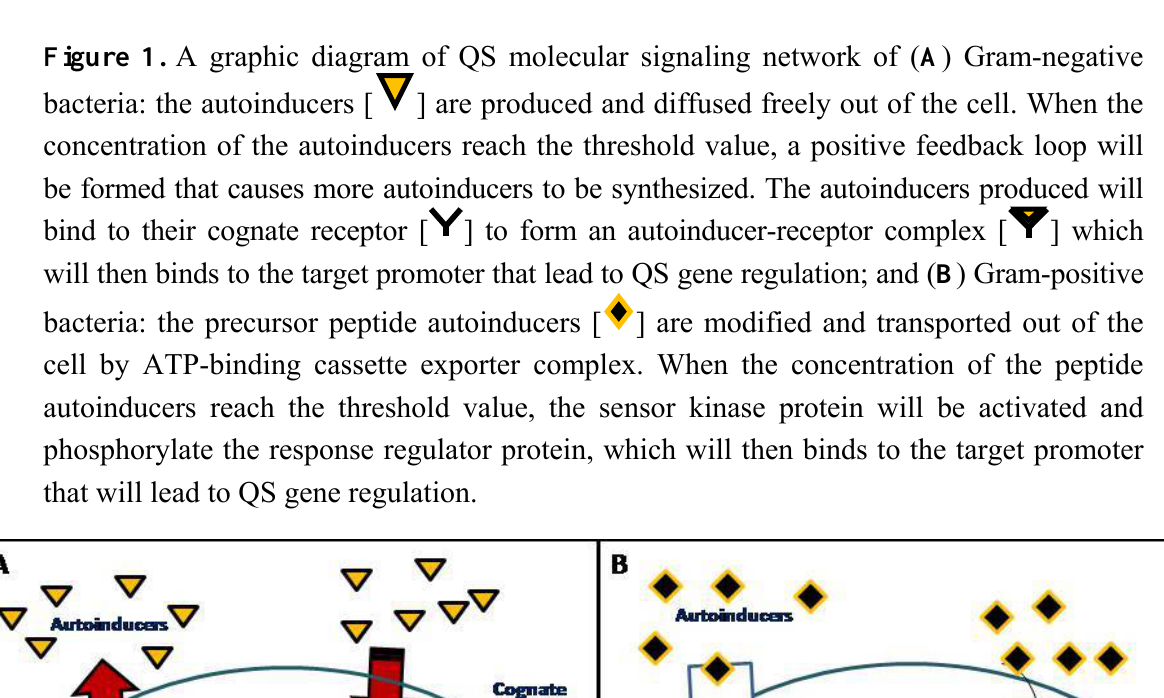
Figure 1. A graphic diagram of QS molecular signaling network of ( A ) Gram-negative bacteria: the autoinducers